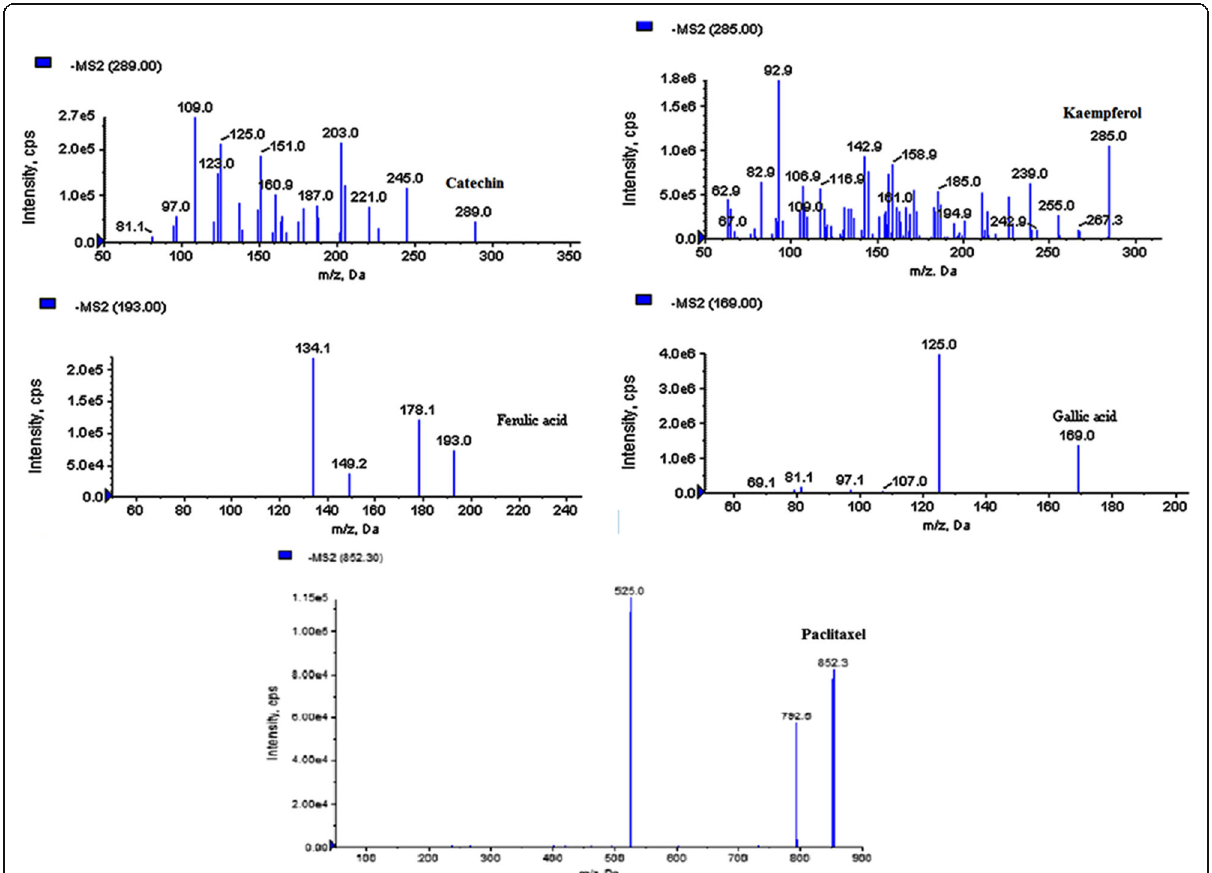
Fig. 7 MS/MS spectra of target phenolic and anticancerous compounds